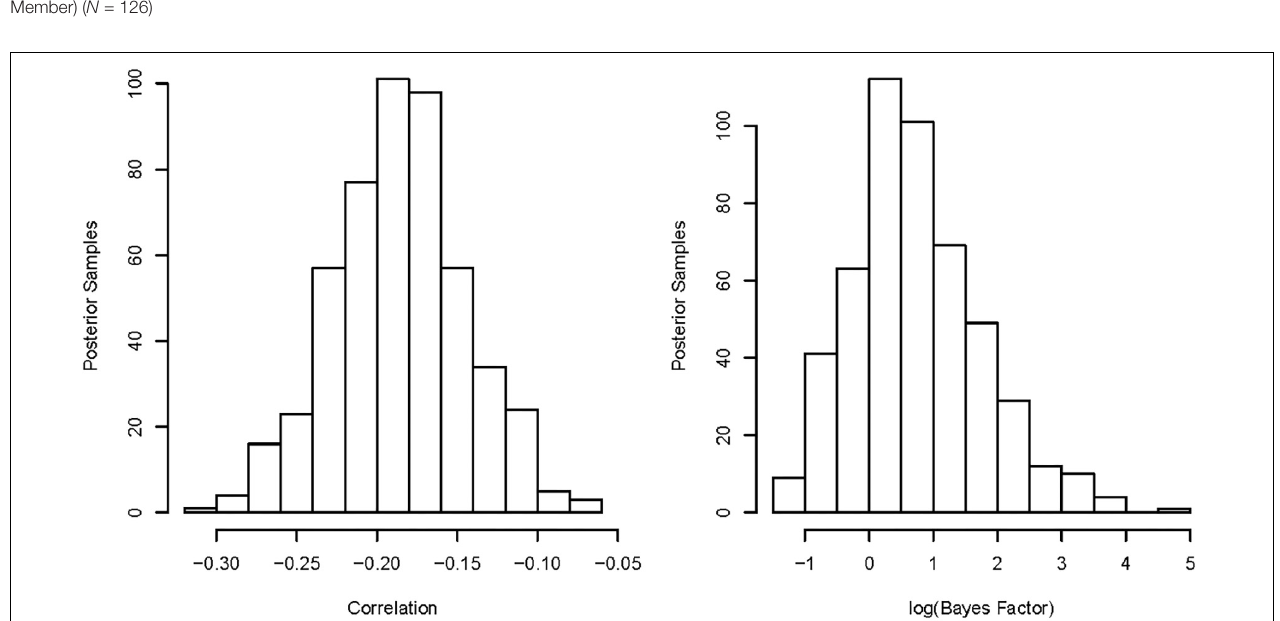
FIGURE 3 | Left: histogram of the estimated correlations between the natural logarithms of our measure of early life adversity and decision threshold, with different correlations reflecting different samples of decision threshold from the posterior distribution. The chosen sample of decision threshold appears to have a large impact on the estimated correlation between the variables, ranging from –0.31 to –0.07, suggesting a great deal of uncertainty in the true correlation. Right: histogram of the estimated Bayes factors for evidence in favor of a correlation existing between our measure of early life adversity and decision threshold, with different Bays factors reflecting different samples of decision threshold from the posterior distribution. Note that we display the natural logarithm of the Bayes factor within this plot for ease of interpretation, where 0 indicates equal evidence for each hypothesis, 1 indicates that the alternative is e (i.e., Euler’s number) times more likely, and –1 indicates that the null is e times more likely. The chosen sample of decision threshold appears to have a large impact of the inference made about the correlation, ranging from moderate evidence in favor of the null, to strong evidence in favor of the